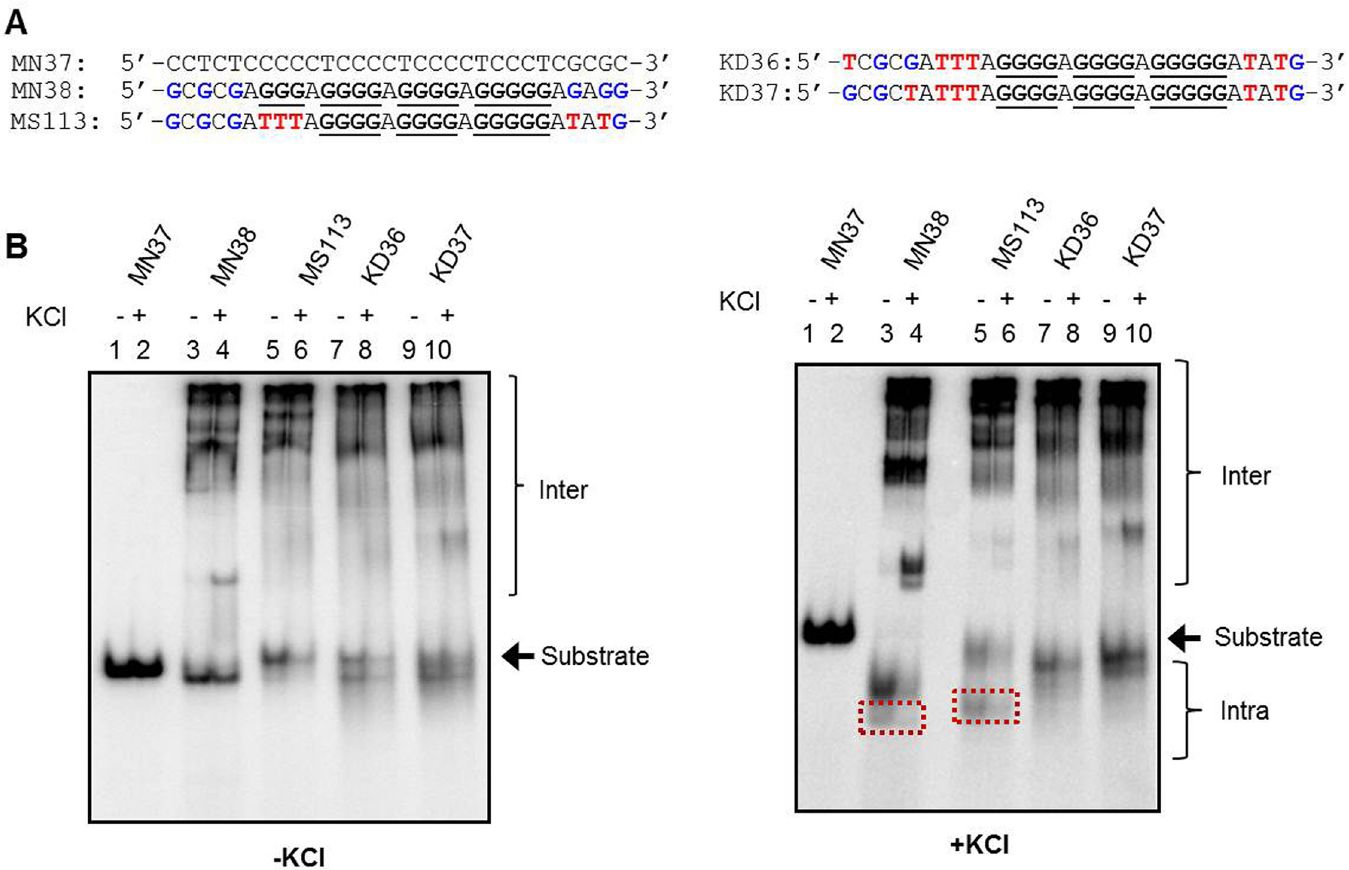
Fig 4. Evaluation of role of individual guanines in a GNGNG motif during G-quadruplex formation. (A) The oligomeric DNA sequence with mutations were made using MS113 as template wherein the guanines in the first GNG motifs were altered sequentially to thymine (indicated in red) generating KD36 and KD37. (B) The G- and C-rich strands along with the mutants were incubated in the presence (+) or absence (-) of KCl (100 mM) and resolved in the absence (left panel) or presence (right panel) of KCl (100 mM), in the gel and running buffer. The substrate, intramolecular (Intra) and intermolecular (Inter) quadruplex structures are indicated. The red boxed “ intra ” indicate intramolecular G-quadruplex species involving GNG motifs.